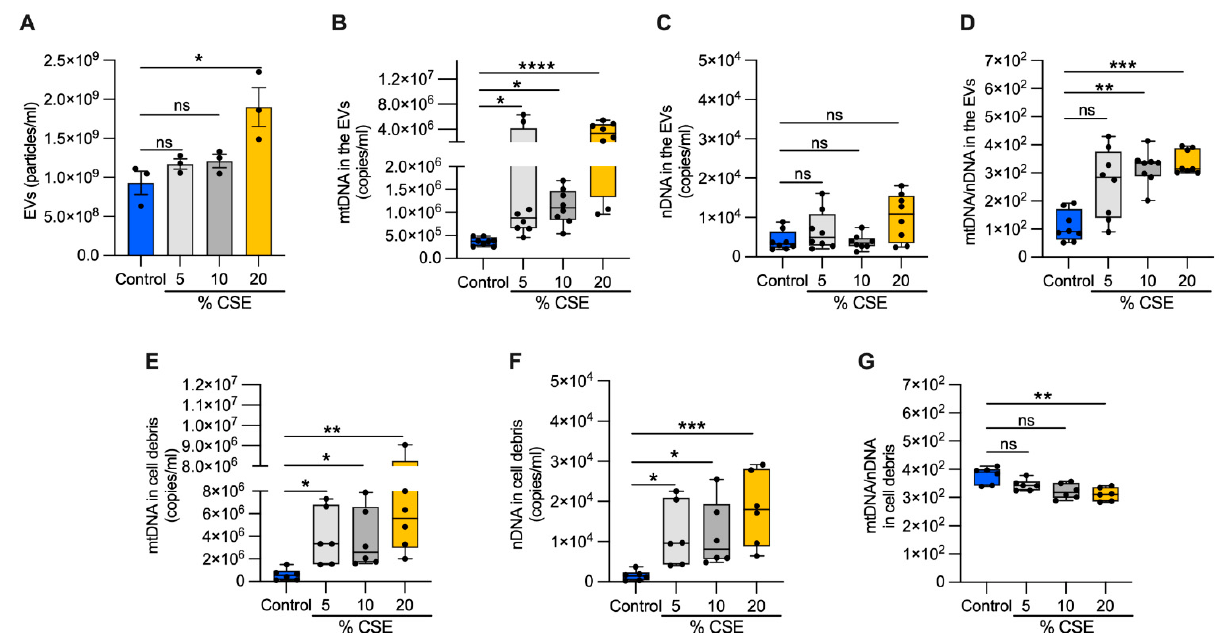
Figure 3. Exposure to CSE promotes mtDNA release in EVs. ( A ) Bar graph showing the EV number (particles/mL) isolated from the extracellular milieu of BEAS ‐ 2B exposed for 24 h to CSE exposure; box and whisker plots of the ( B ) mtDNA and ( C ) nDNA contents; ( D ) the mtDNA/nDNA ratio from isolated EVs as well as the ( E ) mtDNA and ( F ) nDNA content; ( G ) the mtDNA/nDNA ratio from isolated cell debris. (A) Data are shown as mean ± SEM of independent experiments indicated as a circle ( n = 3). (B–G) In the box and whisker plot, each circle represents the value of an independent experiment ( n ≥ 6). CSE, cigarette smoke extract; control, CSE ‐ unexposed cells. (A–G) ns, no statistical significance; * p < 0.05, ** p <0.01, *** p <0.001, **** p < 0.0001 were determined by one ‐ way ANOVA with multiple comparisons and Kruskal–Wallis’s test relative to the control.